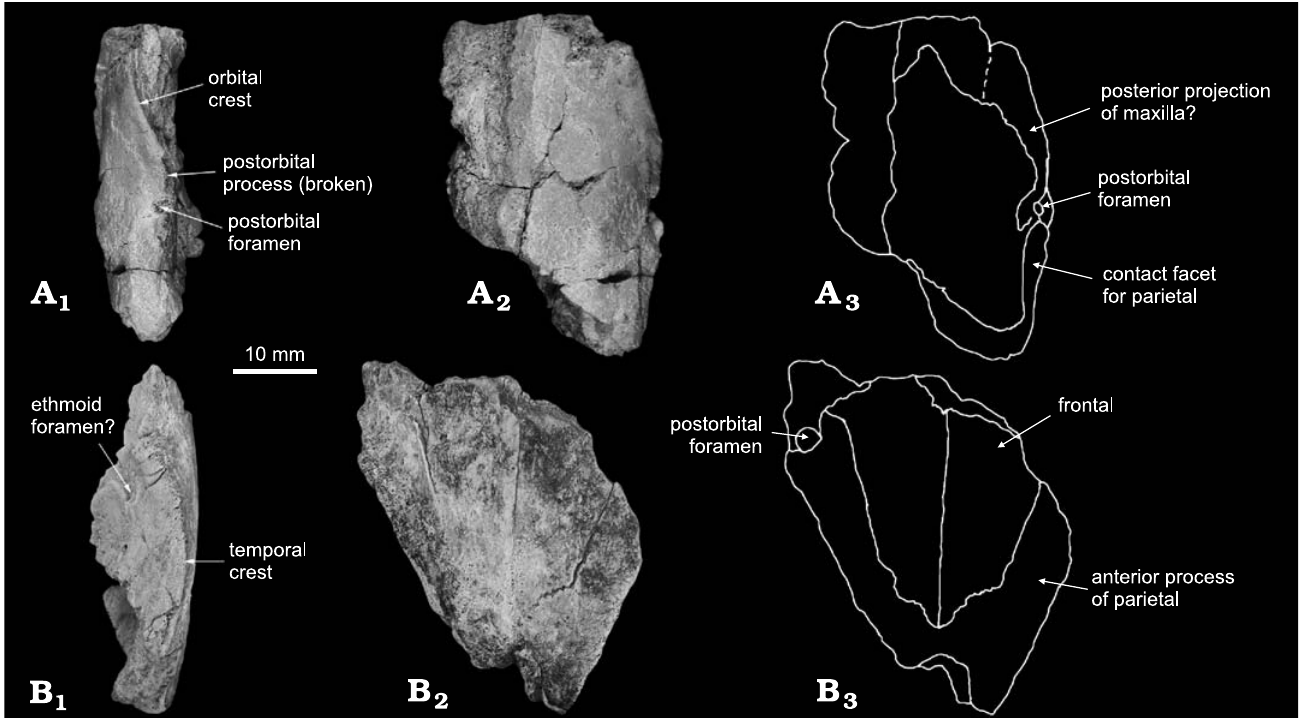
Fig. 9. Skull fragments of multituberculate mammal Sphenopsalis nobilis Matthew, Granger, and Simpson, 1928 from the upper Paleocene Nomogen beds at the Erden (Urtyn) Obo locality, Inner Mongolia, China . A . IVPP V19025, skull fragment showing the orbital crest in lateral (A 1 ) and dorsal (A 2 , A 3 ) views. B . IVPP V19029, skull fragment showing the temporal crest in lateral (B 1 ) and dorsal (B 2 , B 3 ) views. The anterior end of each element is toward upside. Photographs (A 1 , A 2 , B 1 , B 2 ), explanatory drawings (A 3 , B 3